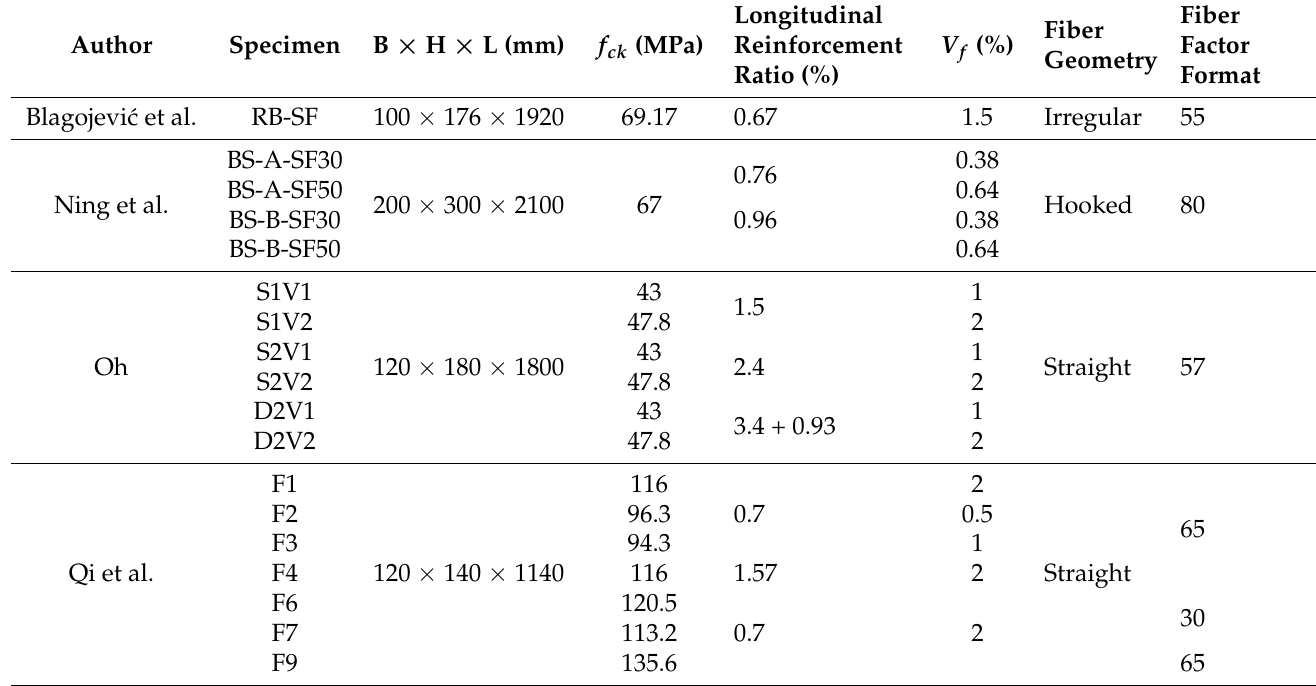
Table A1. Properties of specimens used for numerical model validation.